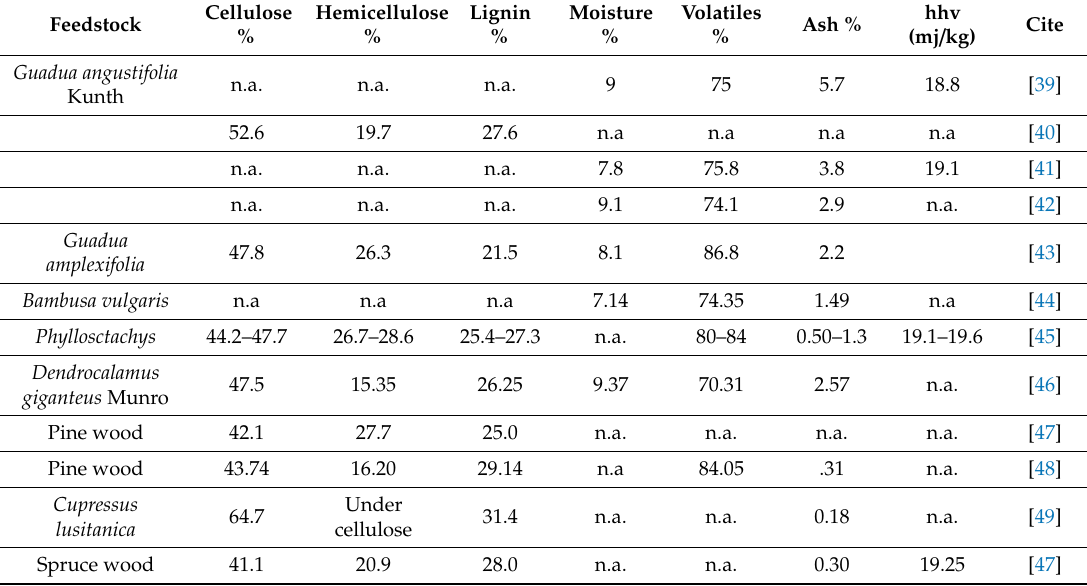
Table 1. Comparison of selected properties from selected feedstocks.